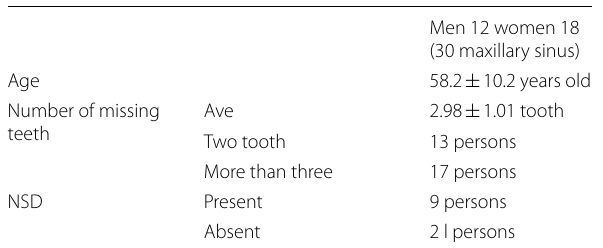
Table 1 Patient data